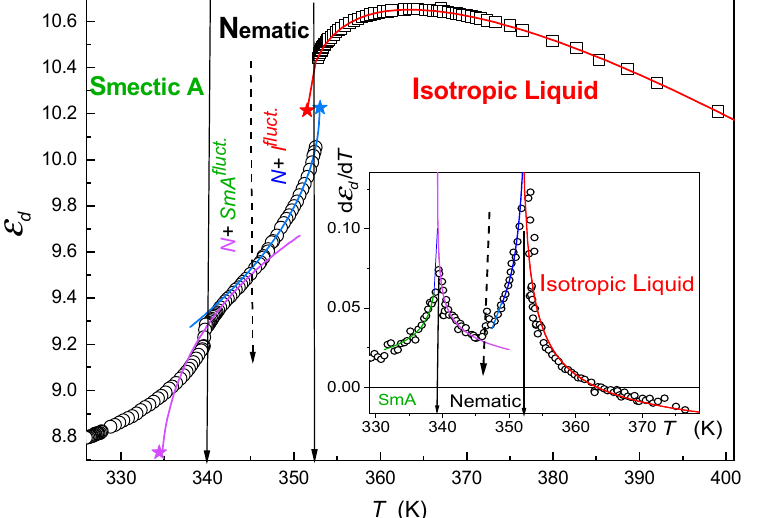
Figure 1. The temperature evolution of dielectric constant in the isotropic liquid and liquid crystalline mesophases of 8OCB. The latter is presented by the mean dielectric constant 𝜀 (cid:3031) = (2𝜀 (cid:2884) + 𝜀 ∥ )/3 . Solid curves represent best fits using Equations (2)–(4). Stars denote the hypothetical extrap- olated temperatures of continuous phase transitions. Solid arrows indicate temperatures of discontinuous I-N and N-SmA phase transitions. The dashed arrow indicates the crossover temperature in the nematic phase between domains dominated by isotropic liquid and SmA pretransitional fluctuations. The inset shows the distortion’s sensitive behavior of the derivative of mean dielectric constant, supporting the picture emerging from the main plot.